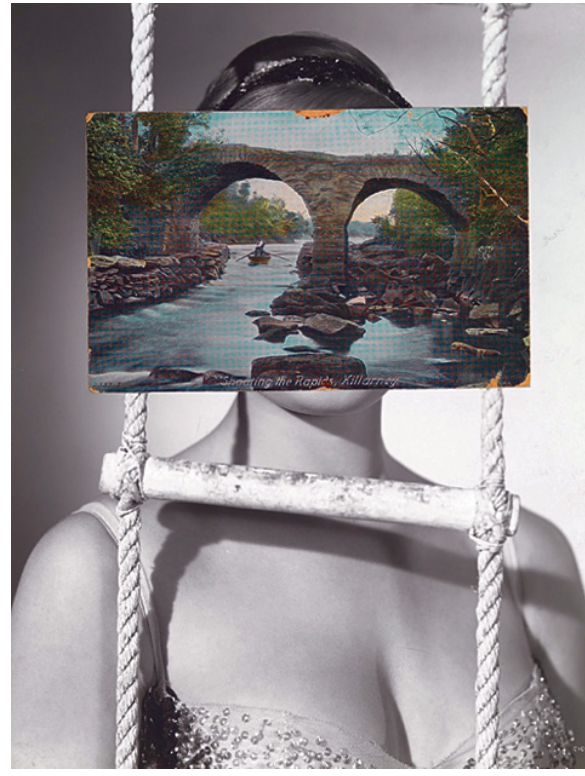
Figure 1: John Stezaker: Mask X, postcard and photograph collage,